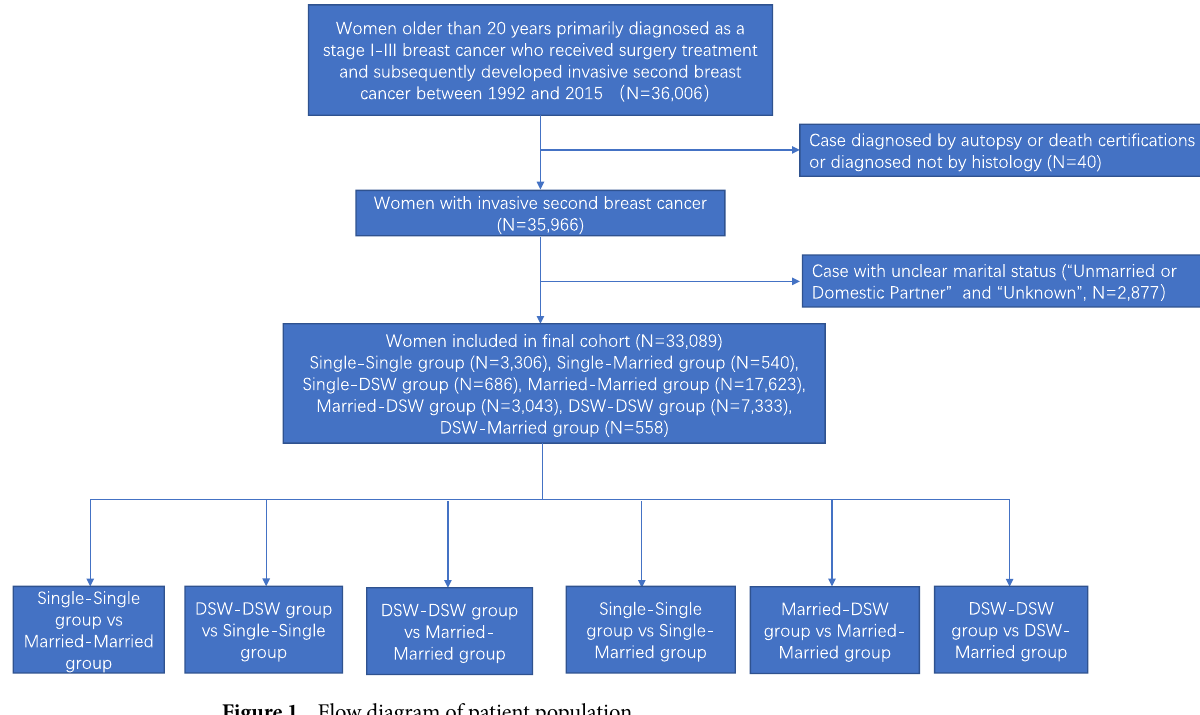
Figure 1. Flow diagram of patient